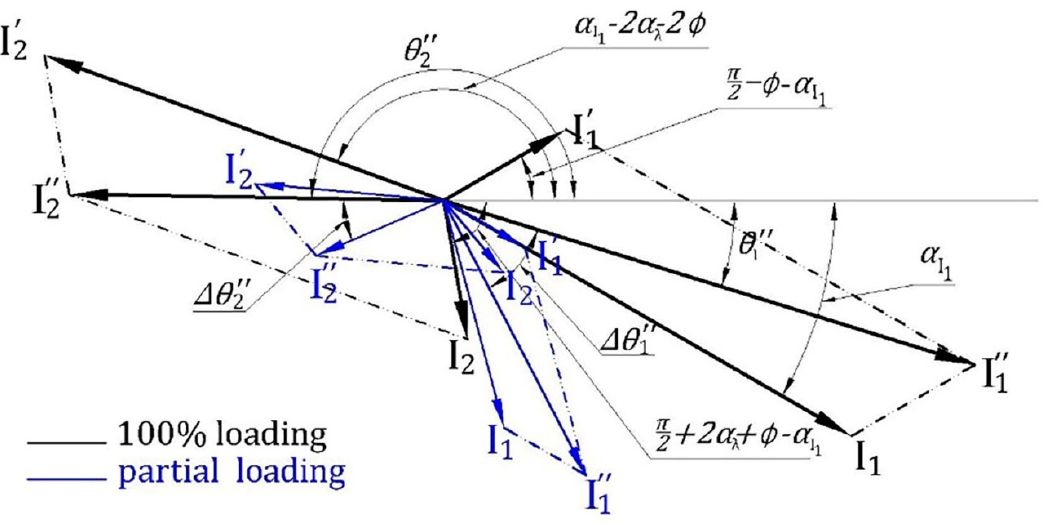
Figure 6. A phasor diagram representing the impact of load variation (from full loading to partial loading) on 𝑖 (cid:2869)(cid:4593)(cid:4593) 𝑎𝑛𝑑 𝑖 (cid:2870)(cid:4593)(cid:4593) current components under healthy conditions.